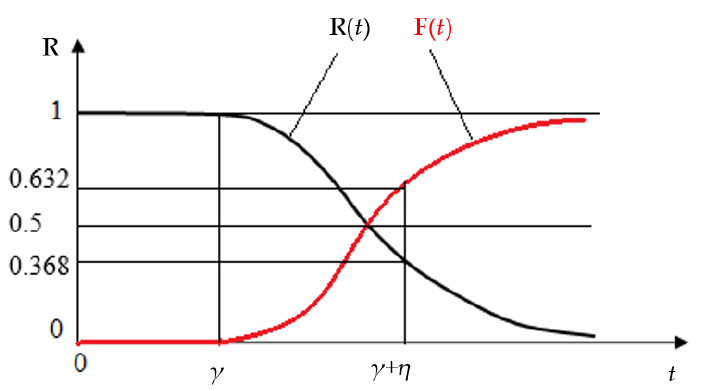
Figure 1. Highlighting parameters γ and η of the three ‐ parametric Weibull model on the graphs R ( t ) and F ( t ).